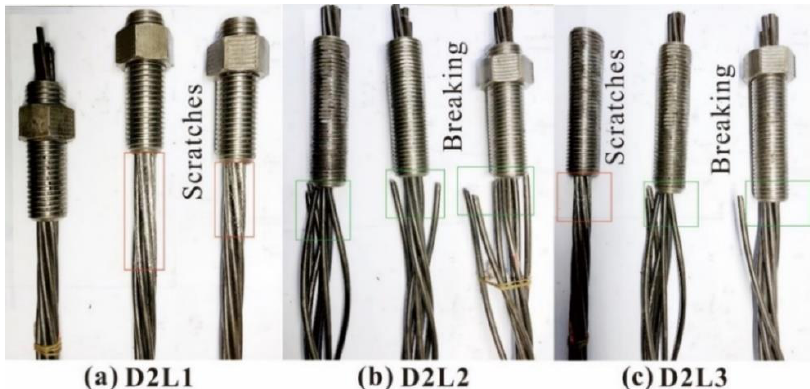
Figure 9. Failure mode of flexible bolts with Ø 33 mm locking casing: ( a ) D2L1, ( b ) D2L2, and ( c ) D2L3.